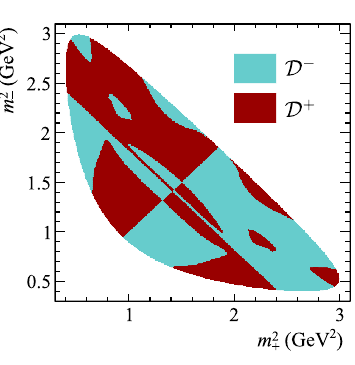
π + π − Dalitz plot into regions D + and S